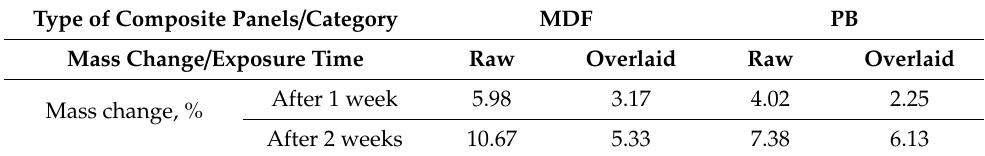
Table 3. Rate of mass change of the composite samples after exposure to humidity conditions. Type of Composite Panels / Category